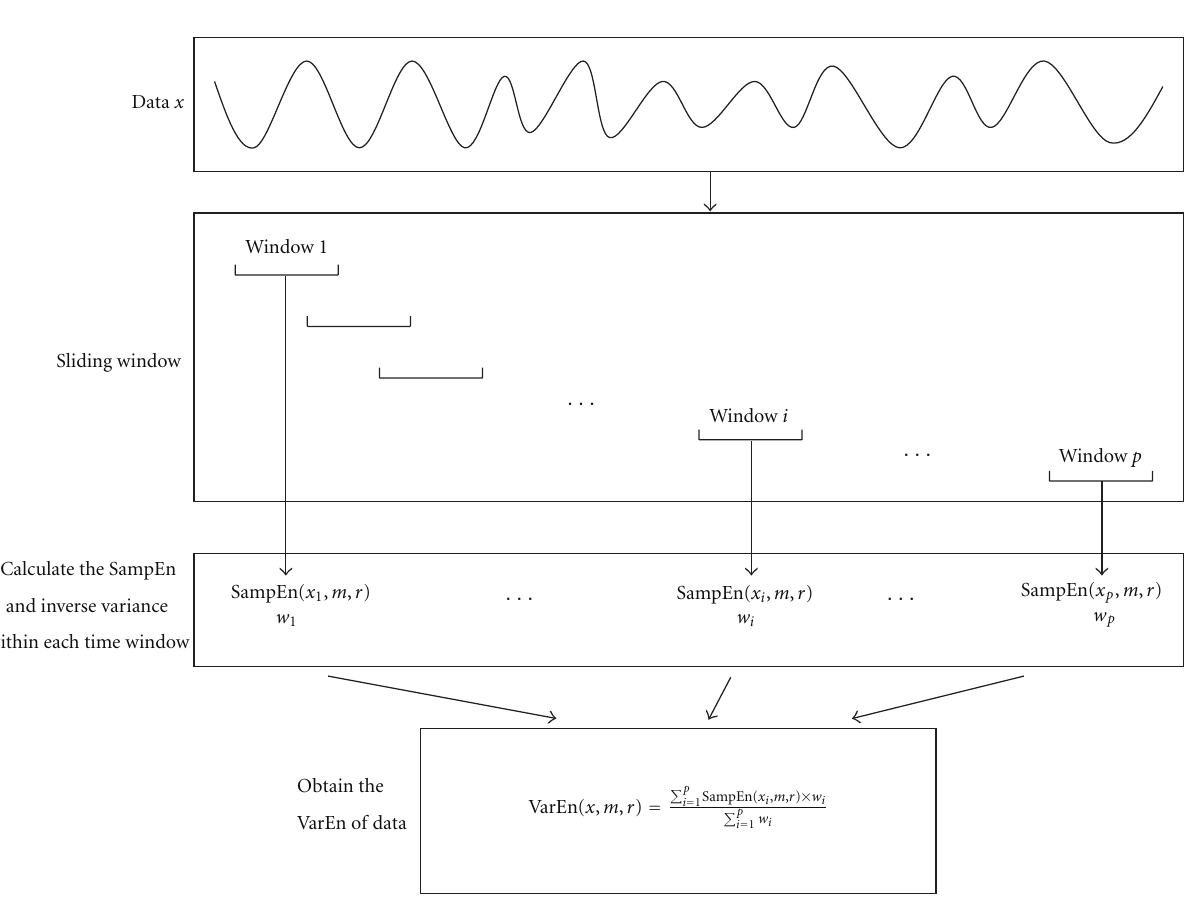
Figure 1: Schematic representation of the proposed variance entropy (VarEn).